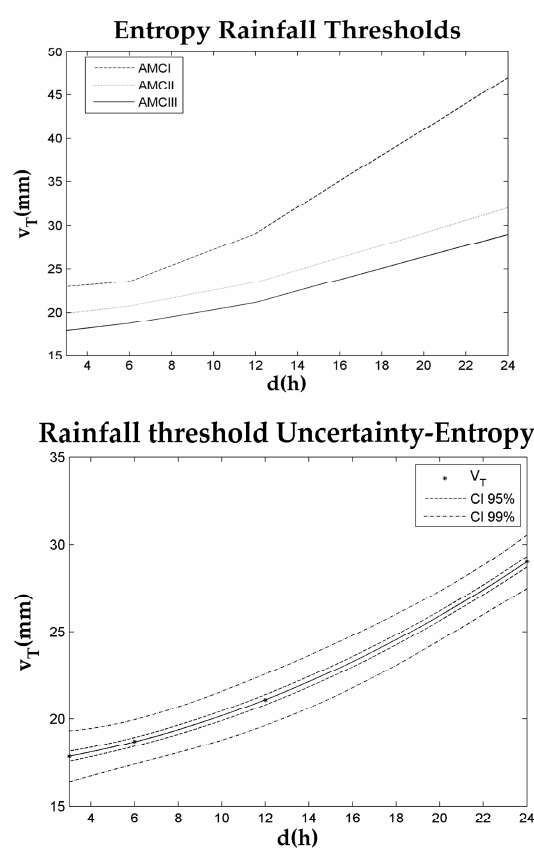
Fig. 7. Threshold values evaluated via the utility-entropy measure of risk approach ( λ = 1) for the Mignone River basin, for all the AMC conditions: AMCI (dashed line), AMCII (dotted line) and AMCIII (solid line) in the upper panel. Uncertainty associated with the AMCIII threshold is in the lower panel.